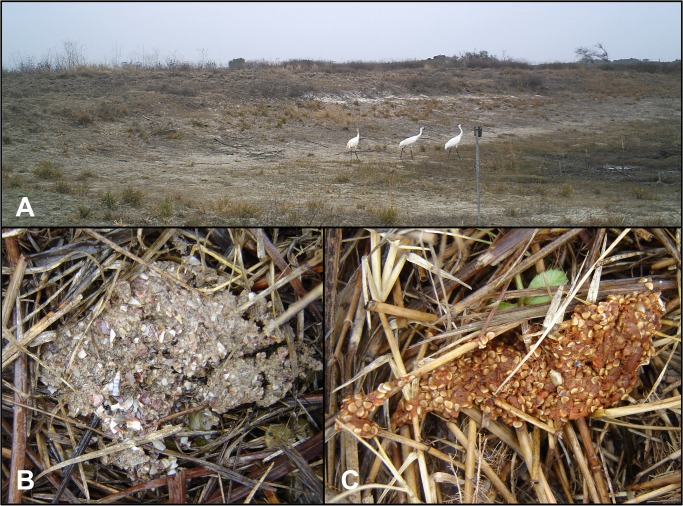
Whooping Crane Scat Collection.Game camera photo of two adult whooping cranes and one juvenile (far left) at a freshwater pond on Aransas National Wildlife Refuge (A). Scat produced by a whooping crane feeding primarily on blue crab and other invertebrates (B) and wolfberry (C). Cranes fed predominantly on wolfberry when the berries were abundant (Nov—Dec), then switched to feed predominantly on crab and other invertebrates. Scat was collected after the cranes naturally left the pond.